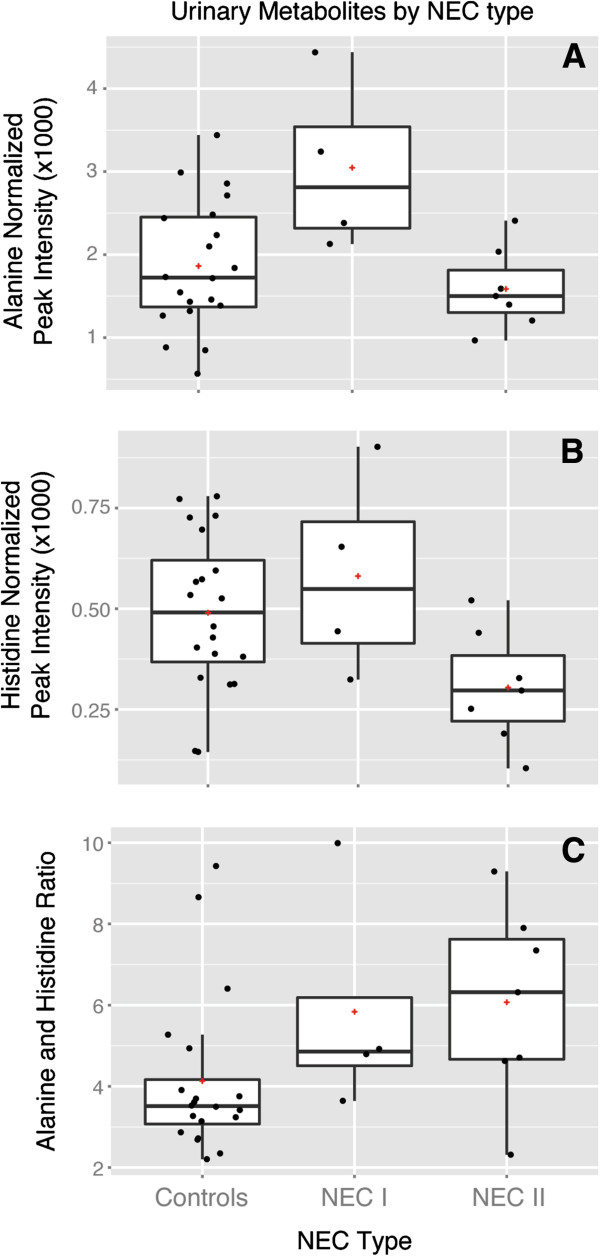
Box plots of urinary alanine and histidine in relation to NEC sub-types versus controls. Urine samples collected during days 4 to 9, restricted to one sample per infant (31 samples). Analysis of urinary alanine, pyridoxine and histidine among NEC-I, NEC-II, death and control subjects using multiple samples per individual (60 samples) is shown in Supplementary Information, Table S2 of Additional file 2. (A) Urinary alanine. Using the Kruskal–Wallis test, urinary alanine was significantly higher in NEC-I vs controls (P = 0.044) and NEC-I than NEC-II (P = 0.023), but did not differ between NEC-II vs controls or all NEC vs controls. (B) Urinary histidine. Using the Kruskal–Wallis test, urinary histidine was significantly lower in NEC-II vs controls (P = 0.023). Histidine also tended to be lower in NEC-II vs NEC-I (P = 0.059), but did not differ between NEC-I vs controls or all NEC vs controls. (C) Ratio of urinary alanine to histidine. Using the Kruskal–Wallis test, the ratio of urinary alanine to histidine was significantly higher in NEC cases overall vs controls (P = 0.023), but did not differ between the NEC sub-types. The optimal cut-point in the alanine:histidine ratio to differentiate NEC cases from controls was identified as a ratio greater than 4 (predictive value 78%, P = 0.007). NEC: necrotizing enterocolitis.